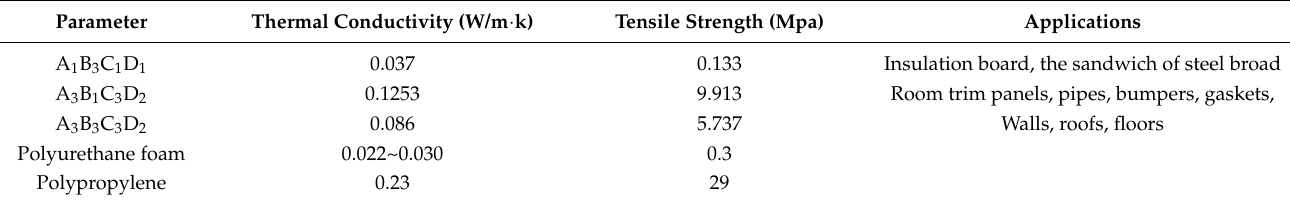
Table 9. Performance and application of the